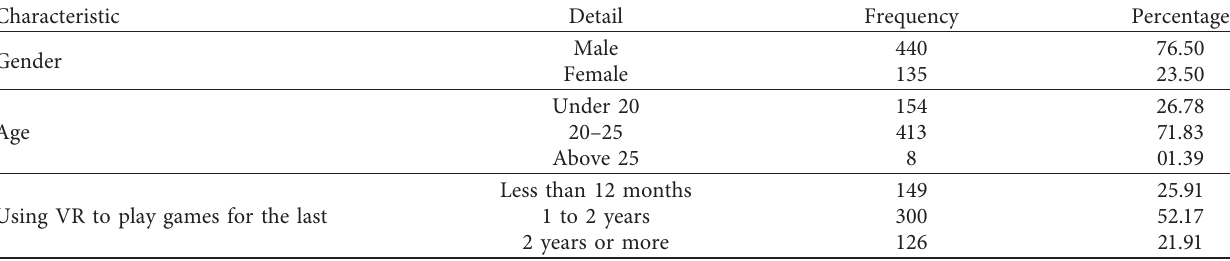
Table 1: Surveyed sample profile.